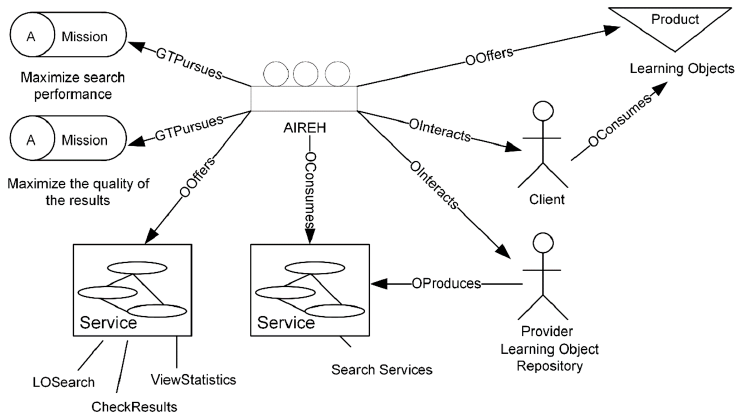
Figure 3. O rganizational model diagram of the AIREH architecture (functional view). Figure 3. Organizational model diagram of the AIREH architecture (functional